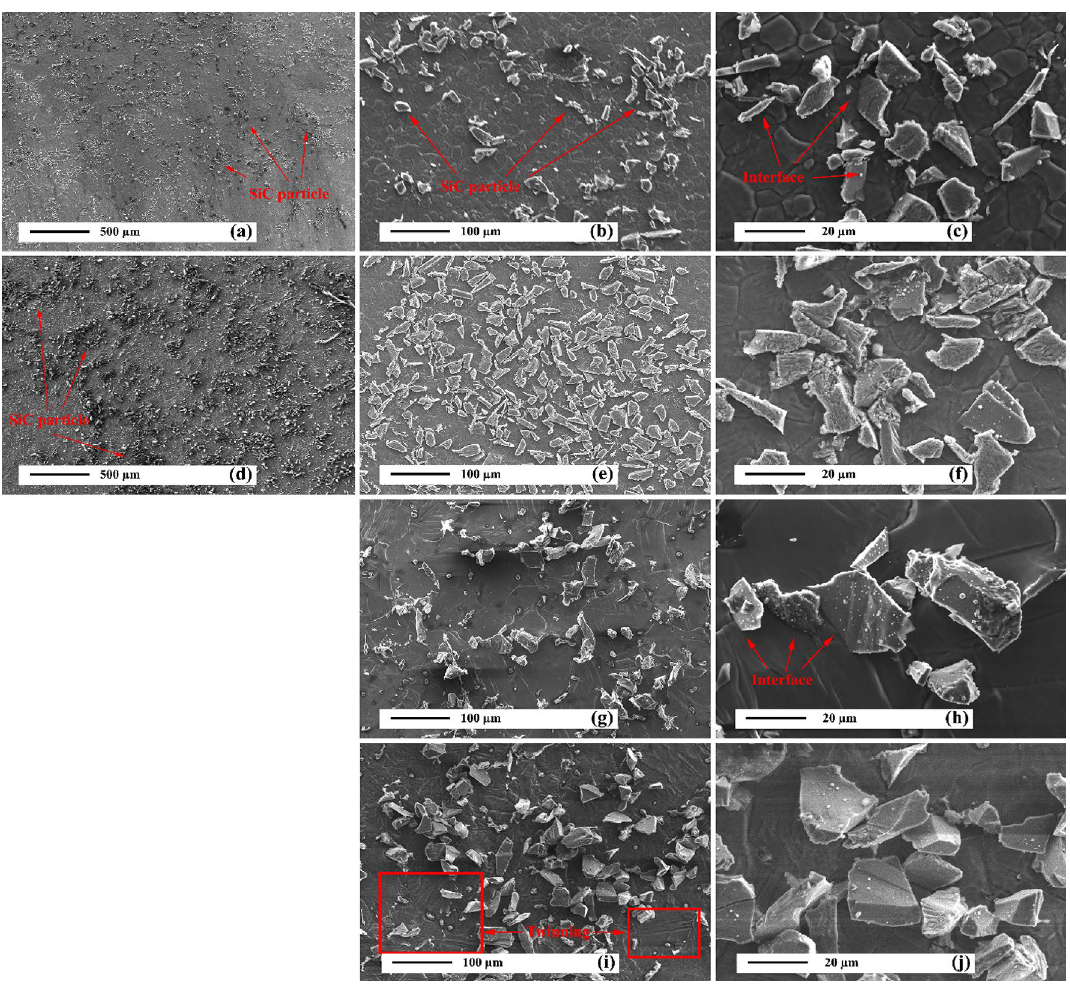
Figure 5. SEM micrographs of composite samples: ( a , b , and c ) as-cast AZ31/5%SiC, ( d , e , and f ) as-cast AZ31/10%SiC, ( g , and h ) AZ31/5%SiC after precipitation hardening, and ( i , and j ) AZ31/10%SiC after precipitation